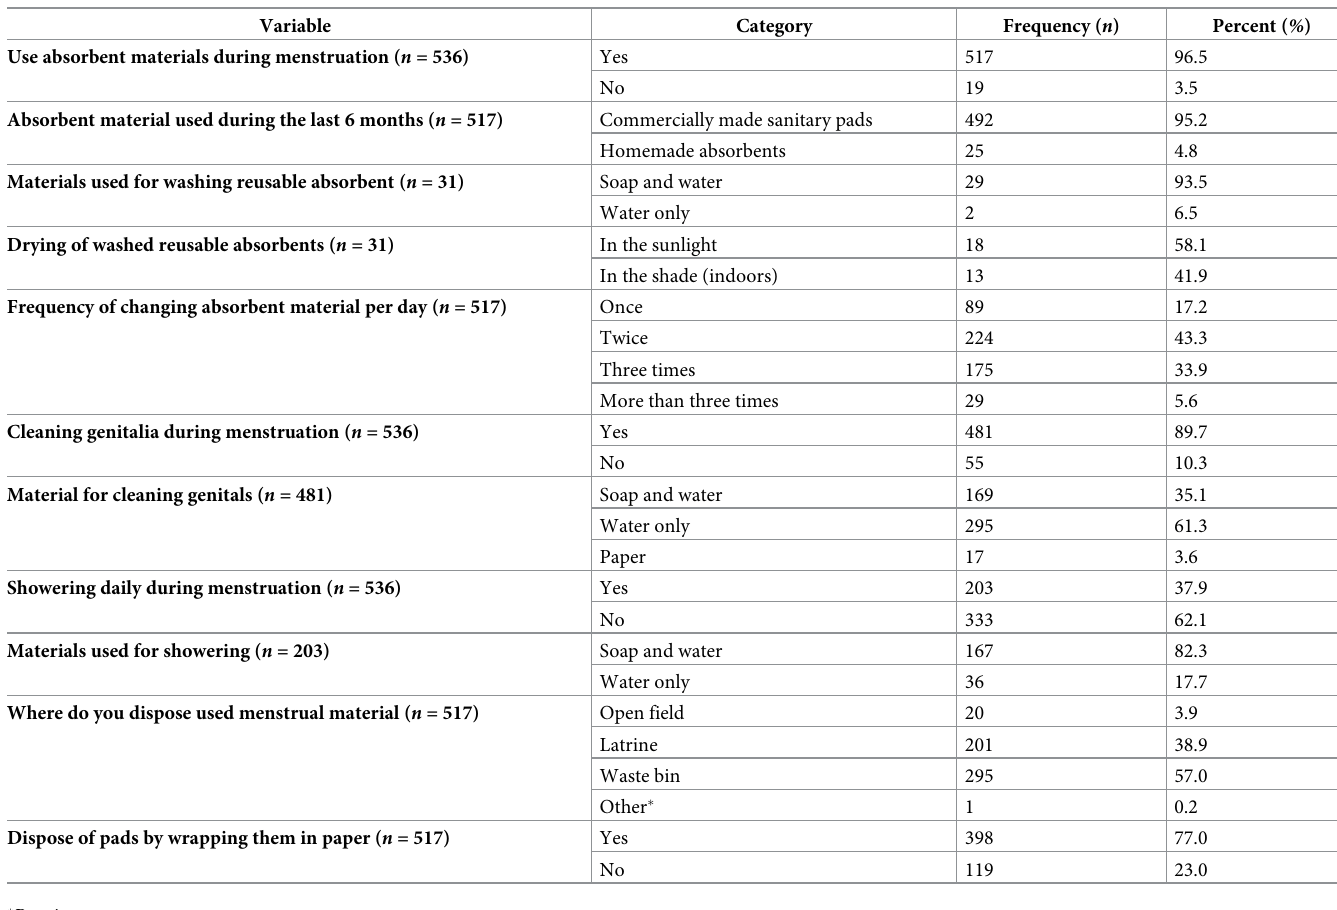
Table 6. Menstrual hygiene practices among high school girls in Dessie City, Amhara Region, northeastern Ethiopia, 27 January to 6 March 2020. Variable Category Use absorbent materials during menstruation ( n = 536)